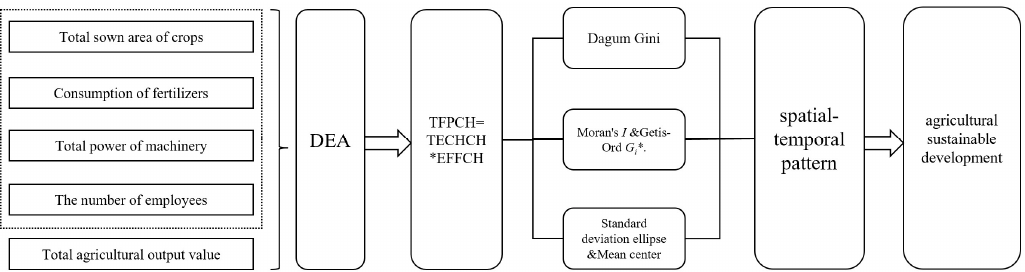
Figure 1. The theoretical framework of this